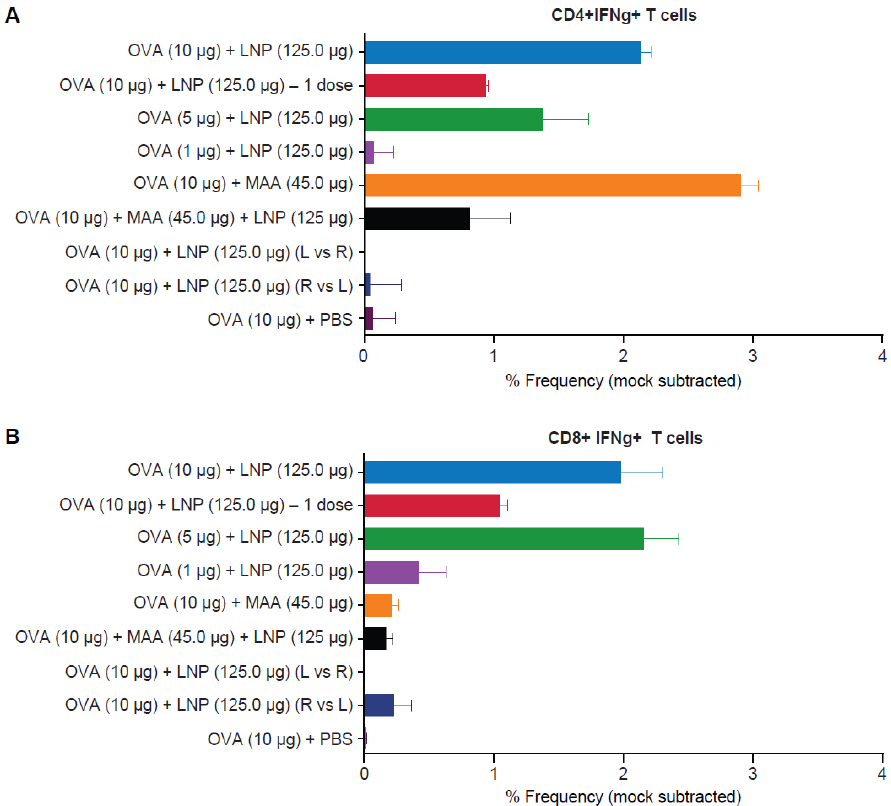
Figure A1. CD4 and CD8 specific T-cell responses to OVA in C57BL/6 mice. OVA antigen-specific CD4+ ( A ) and CD8+ ( B ) T cells that express gamma interferon (IFN-γ) were evaluated by intracellular FACS assay (FACS ICS). Bars represent T-cell events per million splenocytes from five randomly selected mice out of ten immunized mice/group.